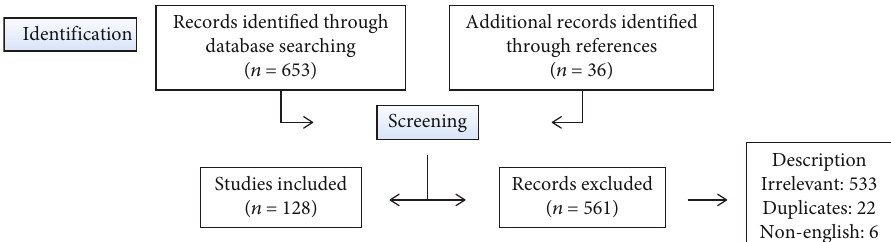
Figure 1: Schematic representation of the study selection to be included in the